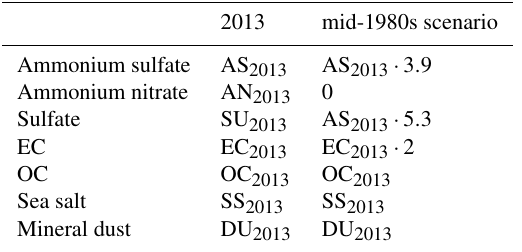
Table 3. Assumptions for the estimation of the aerosol conditions for the mid-1980s over